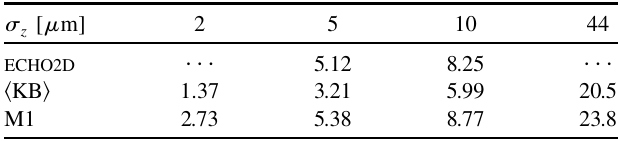
TABLE II. Total kick factor per meter of length calculated using different models and ECHO2D in the sample structure for different bunch length is presented in [ kV = pC m 2